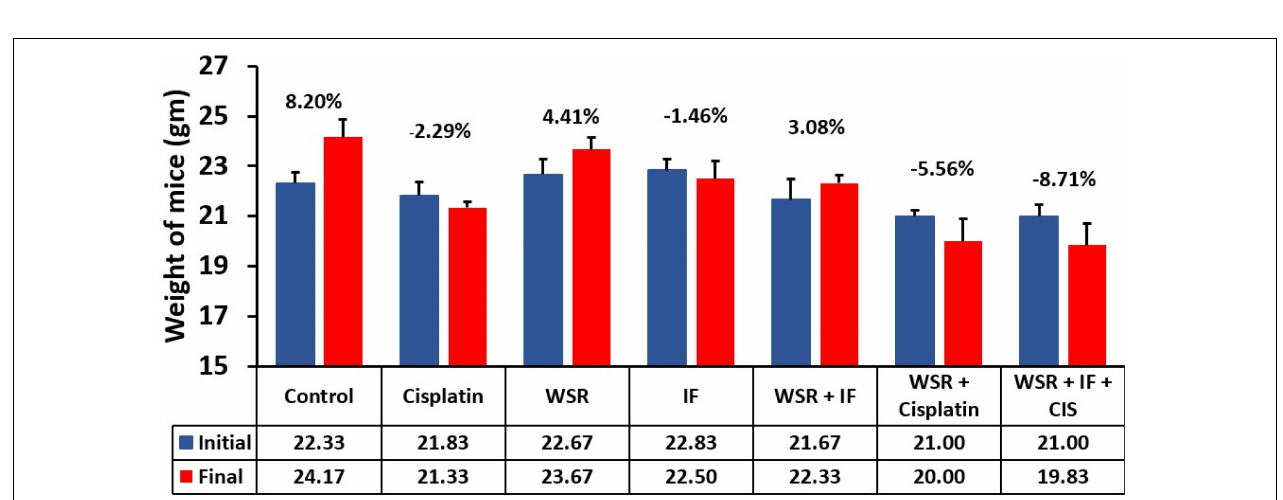
FIGURE 7 | Mice average weight (gm) on days 1 and 10 in all groups compared with each other. (%): percentage of change in body weight. Results are expressed as means ± SEM ( n = 6).